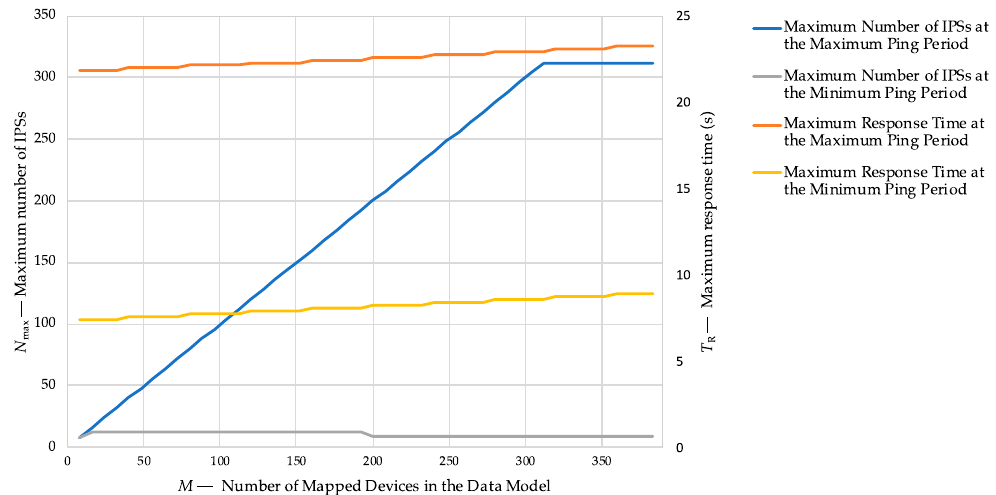
Figure 7. Estimation of the maximum number of IPSs that can be managed by (a single) LoRaWAN GWs and of the maximum expected response time depending on the number of devices mapped in the communication data model.